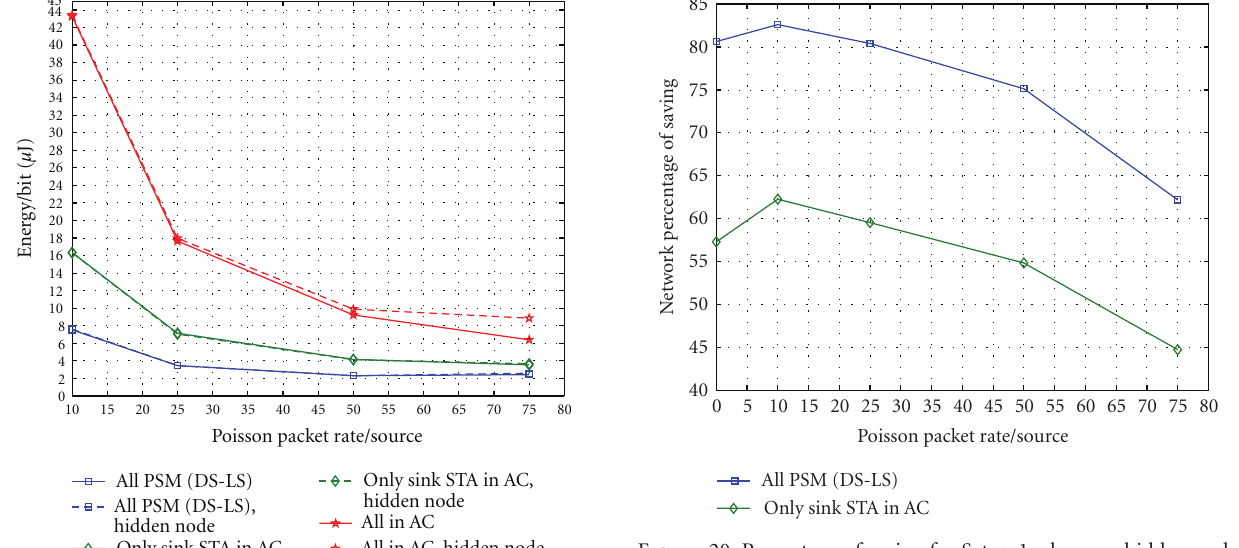
Figure 20: Percentage of saving for Setup 1 where no hidden node